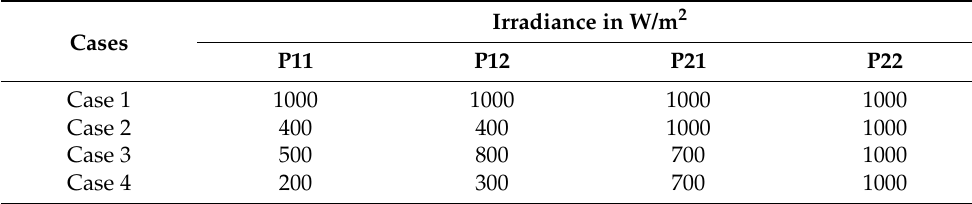
Table 2. Four different cases of PSCs for